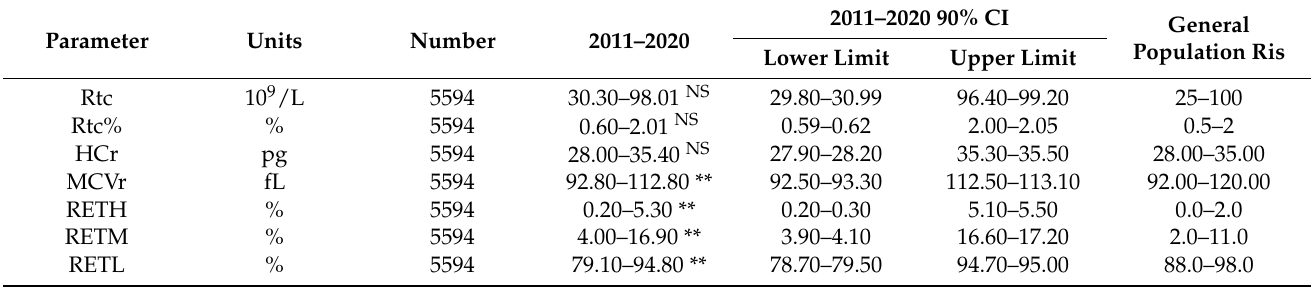
Table 4. Reference intervals (Ris) and basal values for reticulocyte count and associated parameters (females and